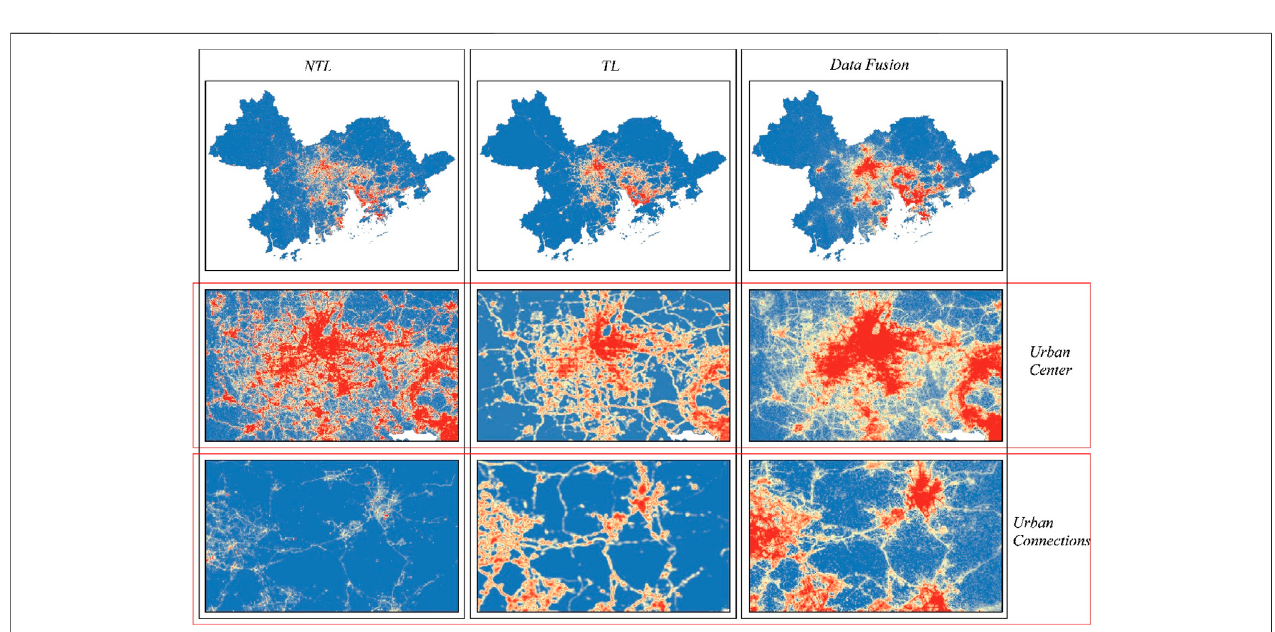
FIGURE 8 | Comparison and analysis of delineation before and after the fusion of NTL and TL data.